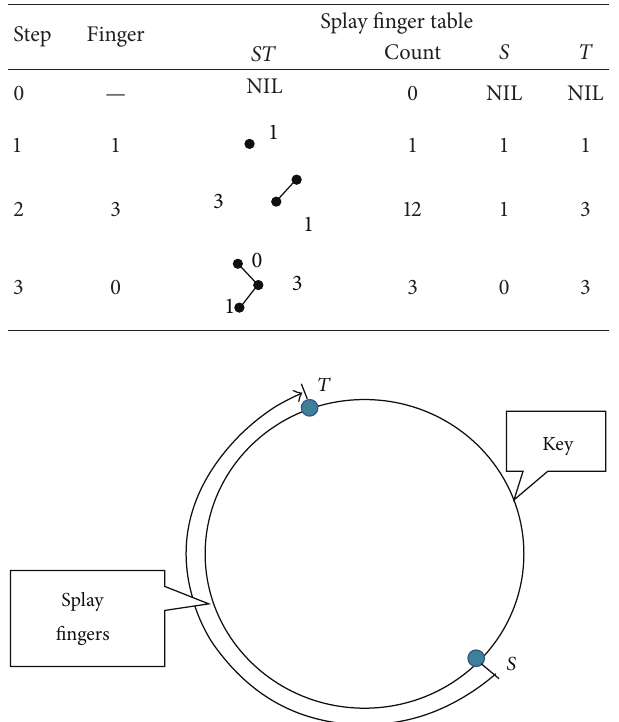
Table 1: Construction of node 0’s splay finger table.